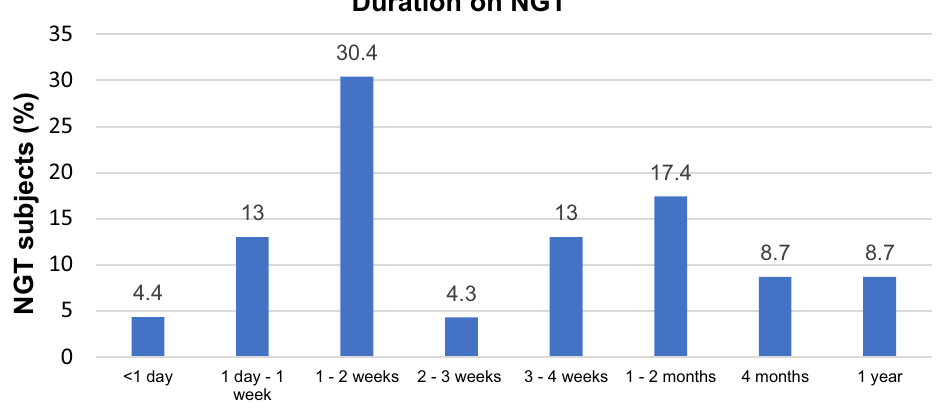
Figure 1. Graph of NGT + NBM subjects by duration on